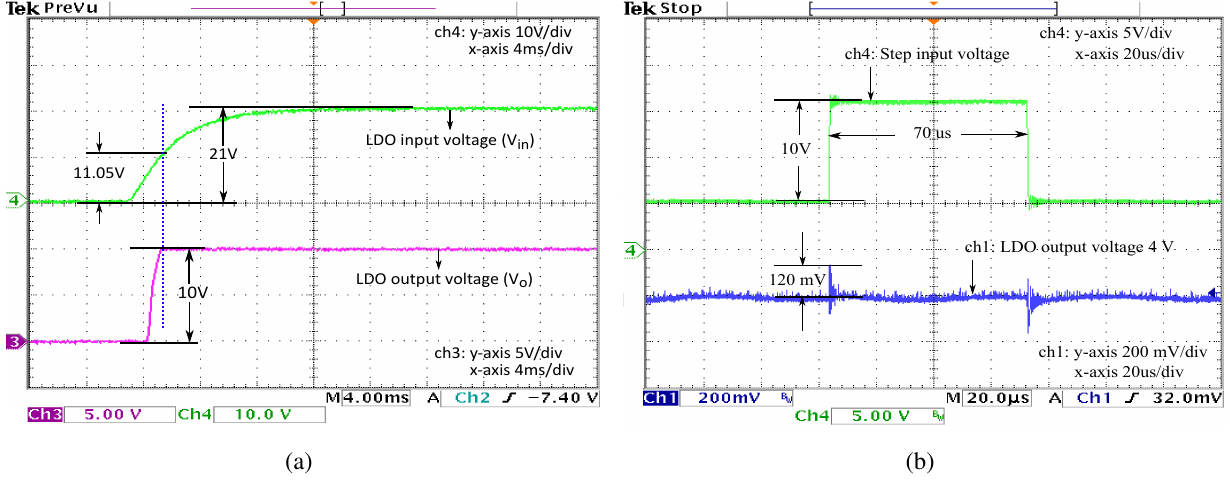
Figure 13. Oscilloscope capture of the transient response of the LDO: ( a ) at start-up for a 10-V output; ( b ) with a step input of 10 V for a 4-V output.